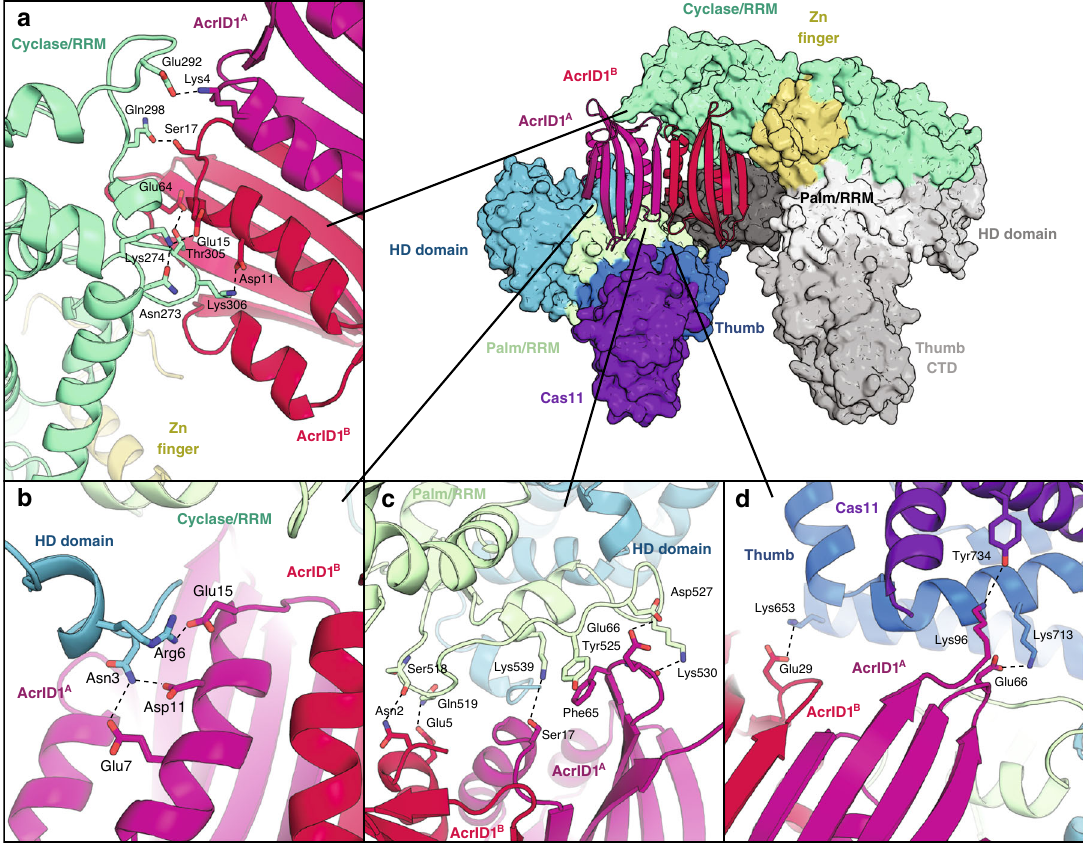
Fig. 3 Details of the interactions between Cas10d and AcrID1. In all panels, hydrogen bonds and charged interactions are shown with labelled residues, dashed lines and with colours as in Fig. 1. a Interactions between AcrID1 A and the Cyclase/RRM domain with relevant residues shown as labelled sticks. b Interactions between AcrID1 A and the HD domain. c Interactions between both monomers of AcrID1 and the Palm/RRM domain. d Interactions between both monomers of AcrID1 and the Thumb/Cas11